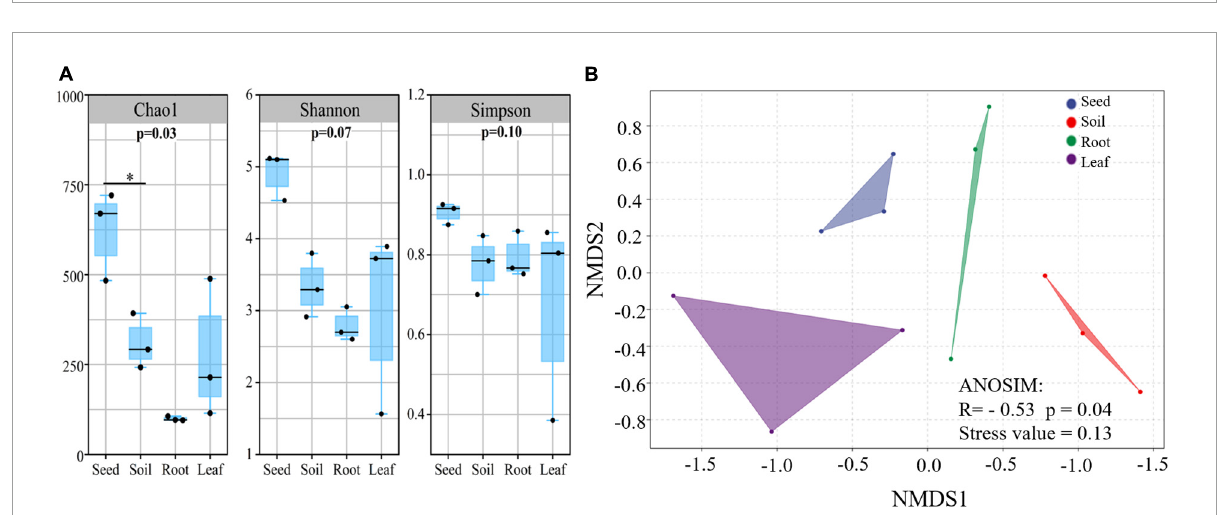
FIGURE3 The alpha (A) and beta (B) diversity of ammonia oxidizing bacteria in different plant parts and soil of E. nutans growing at Maqu Azi station on the QTP ( n = 3). Alpha diversity indices: Chao 1, Shannon and Simpson diversity were estimated using QIIME 2 software. Beta diversity was assessed by non-metric multidimensional scaling (NMDS) using a weighted uniFrac distance matrix using isoMDS function in MASS package in R software.